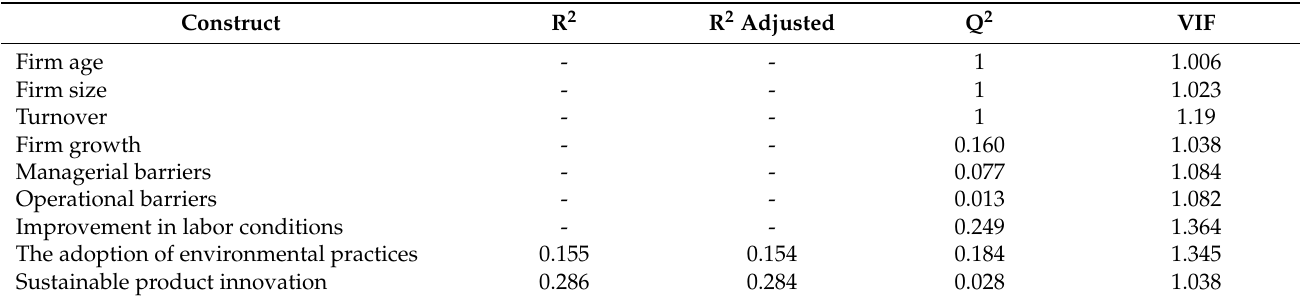
Table 4. Results of the structural model.